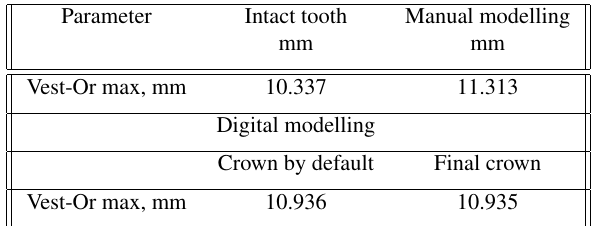
Figure 8. Vest-Or max sections on default (left) and reshaped (right) digital